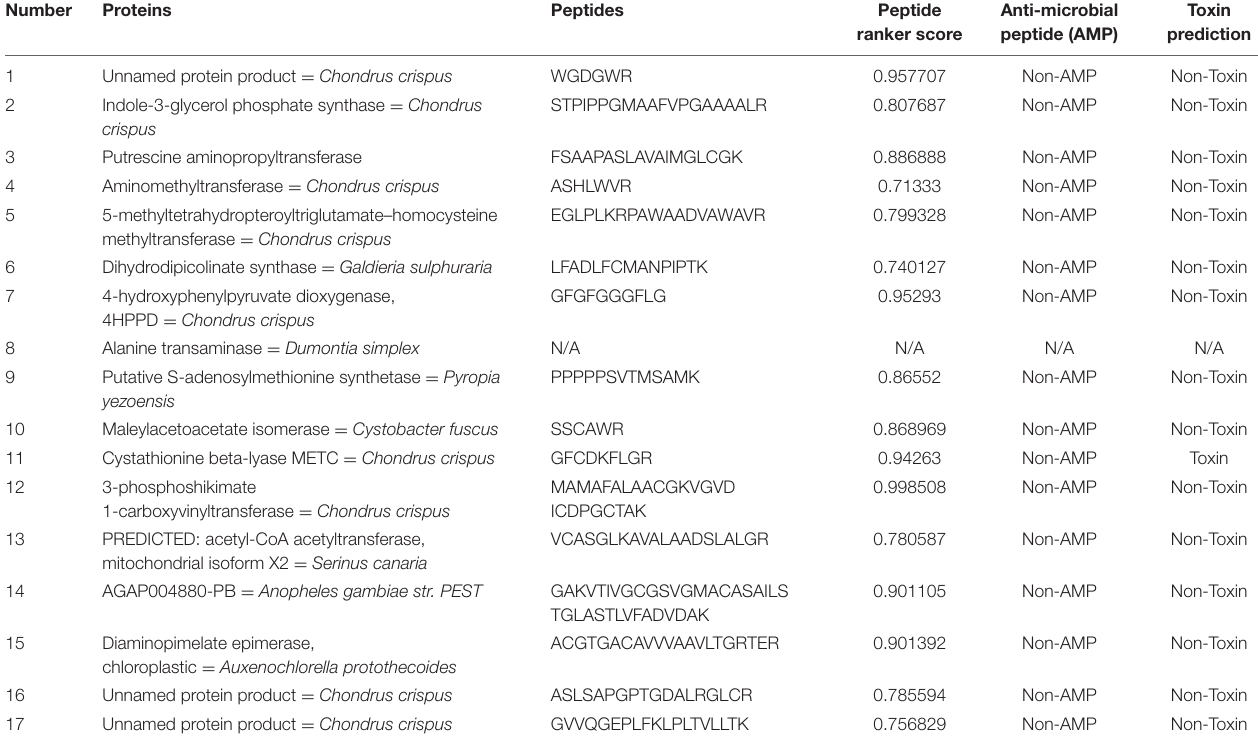
TABLE 5 | Selected potential bioactive peptides of the amino acid metabolism proteome predicted by in silico digestions with trypsin. Number Proteins Peptides Peptide